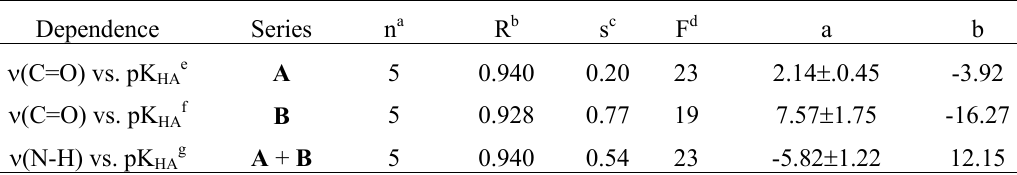
a Number of solvents used in correlation. b Correlation coefficient. c Standard deviation. d Fisher-Snedecor test for parameters significant at the 95 % level. e See correlations No. 11, 13, 15, 17 and 19 in Table 4. f See correlations No. 12, 14, 16, 18 and 20 in Table 4. g See correlations No. 31, 32, 33, 34 and 35 in Table 4.